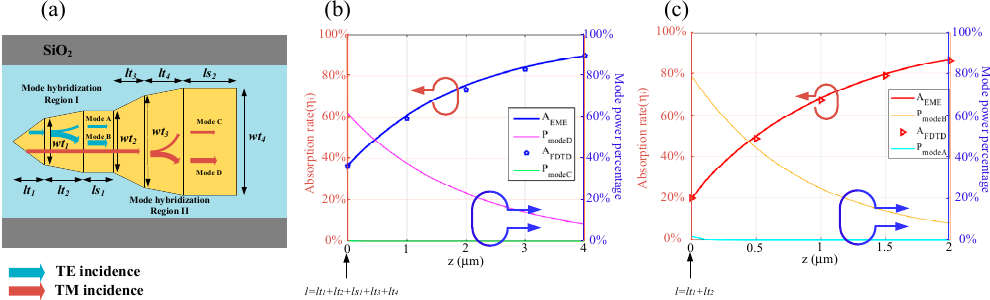
Figure 10. ( a ) Diagrammatic sketch of mode propagation and conversion process under TE and TM incidence in a single layer metal structure; ( b , c ) fitting results of the hybrid modes of power and absorption rate versus mode propagation length after the mode hybridization area. Parameters: ( b ) TM incidence, Au: h m = 5 nm, wt 1 = 0.09 µm, wt 2 = 0.11 µm, wt 3 = 0.25 µm, wt 4 = 0.28 µm; ( c ) TE incidence, Al: h m = 2 nm, wt 1 = 0.1 µm, wt 2 = 0.13 µm, wt 3 = 0.29 µm, wt 4 = 0.31 µm. Other parameters: lt 1 = 0.2 µm, lt 2 = 0.5 µm, lt 3 = 1 µm, lt 4 = 0.5 µm, ls 1 = 2 µm, ls 2 = 4 µm, λ = 2 µm.